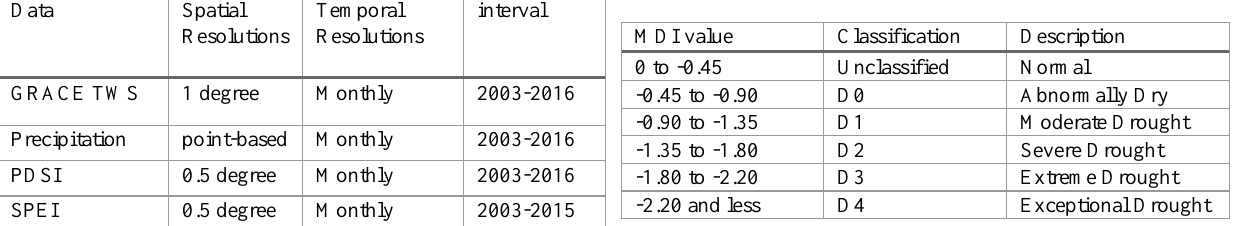
Table 2. Drought classification based on MDI (Manacles, 2014) Therefore, negative residuals are indicating deficits in land